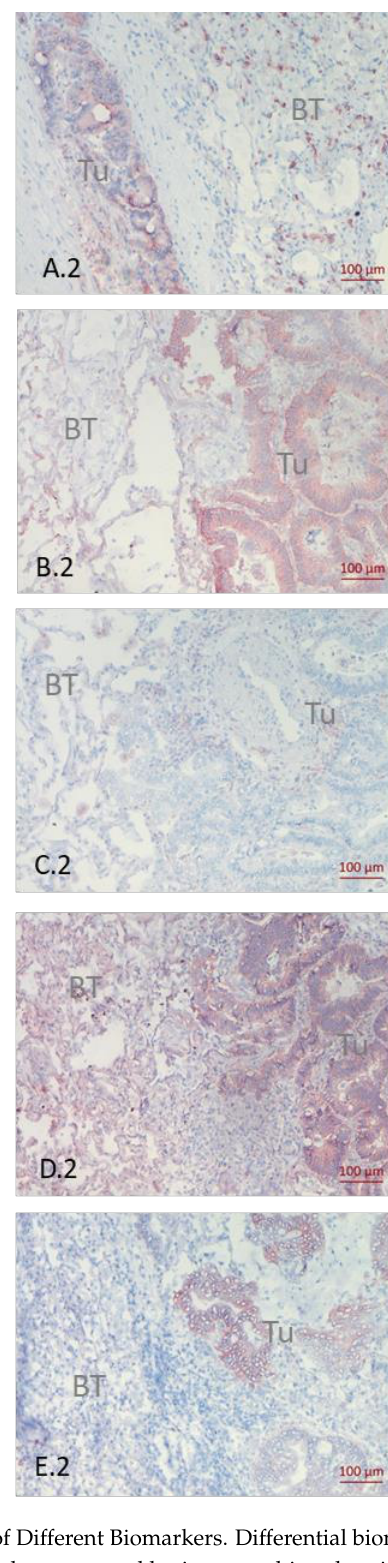
Figure 2. Immunohistochemical Staining of Different Biomarkers. Differential biomarker expression between liver ( 1 ) and lung ( 2 ) metastases demonstrated by immuno-histochemistry. ( A ), CD44v6; ( B ) , α2β1; ( C ), PD-L1; ( D ), IGF-1R; ( E ), EGFR; Tu , tumor tissue; BT , Benign tissue.